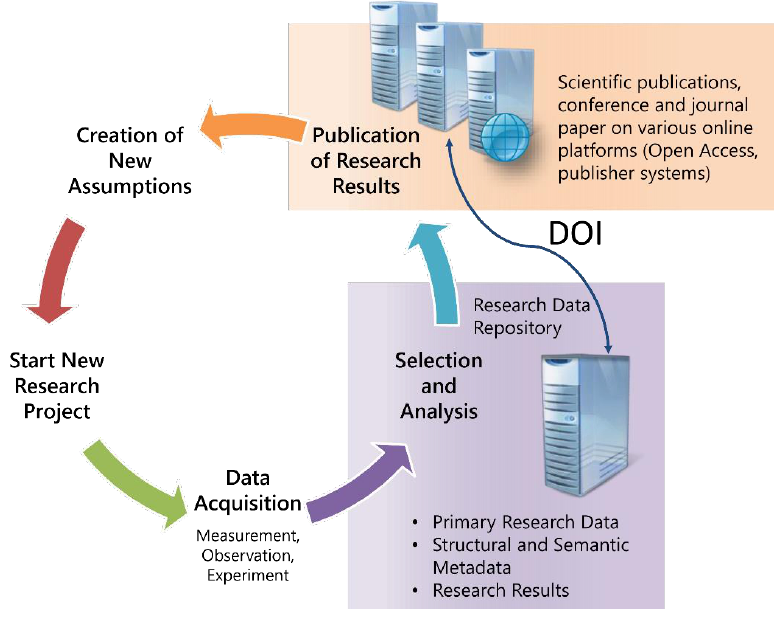
Figure 2. Desired Lifecycle of Research Data in CRC 840.